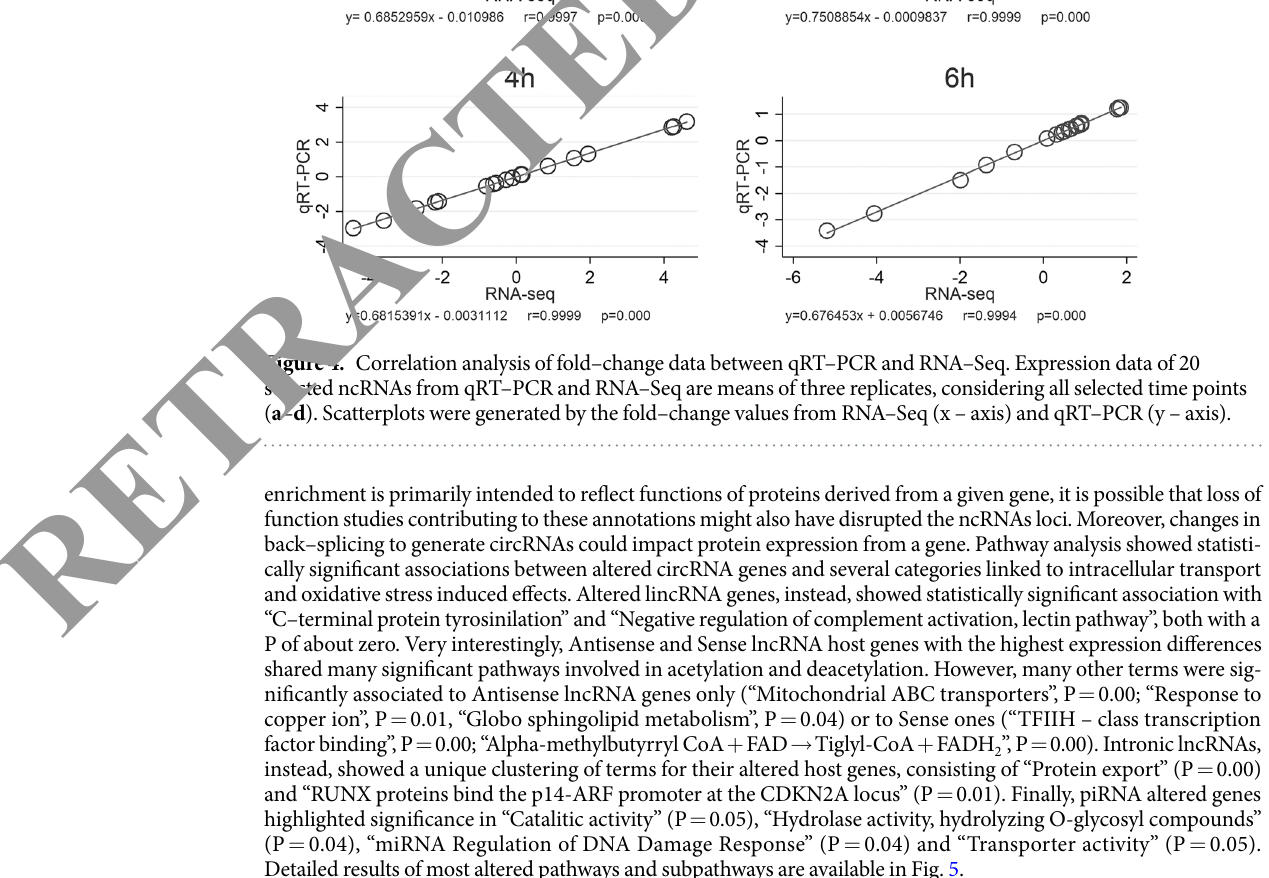
Detailed results of most altered pathways and subpathways are available in Fig. 5.